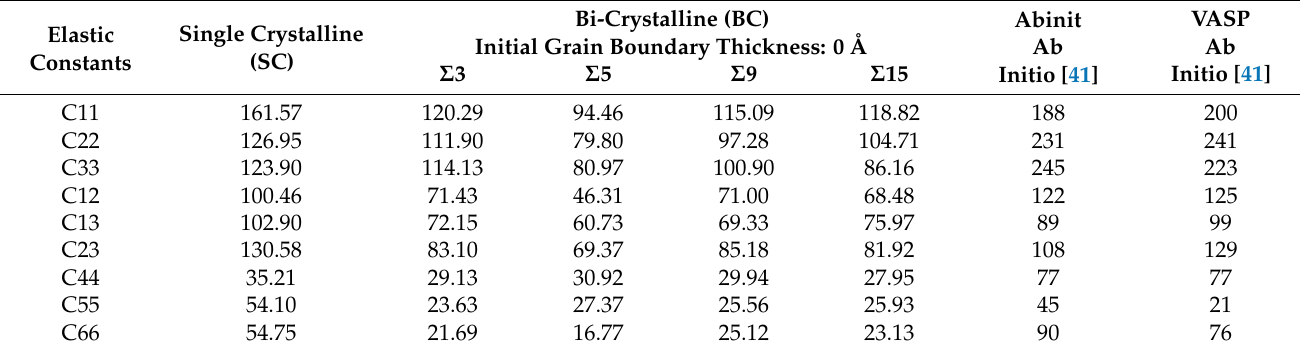
Table 3. BC simulation cases yielded lower elastic modulus (49–59 GPa) compared with the